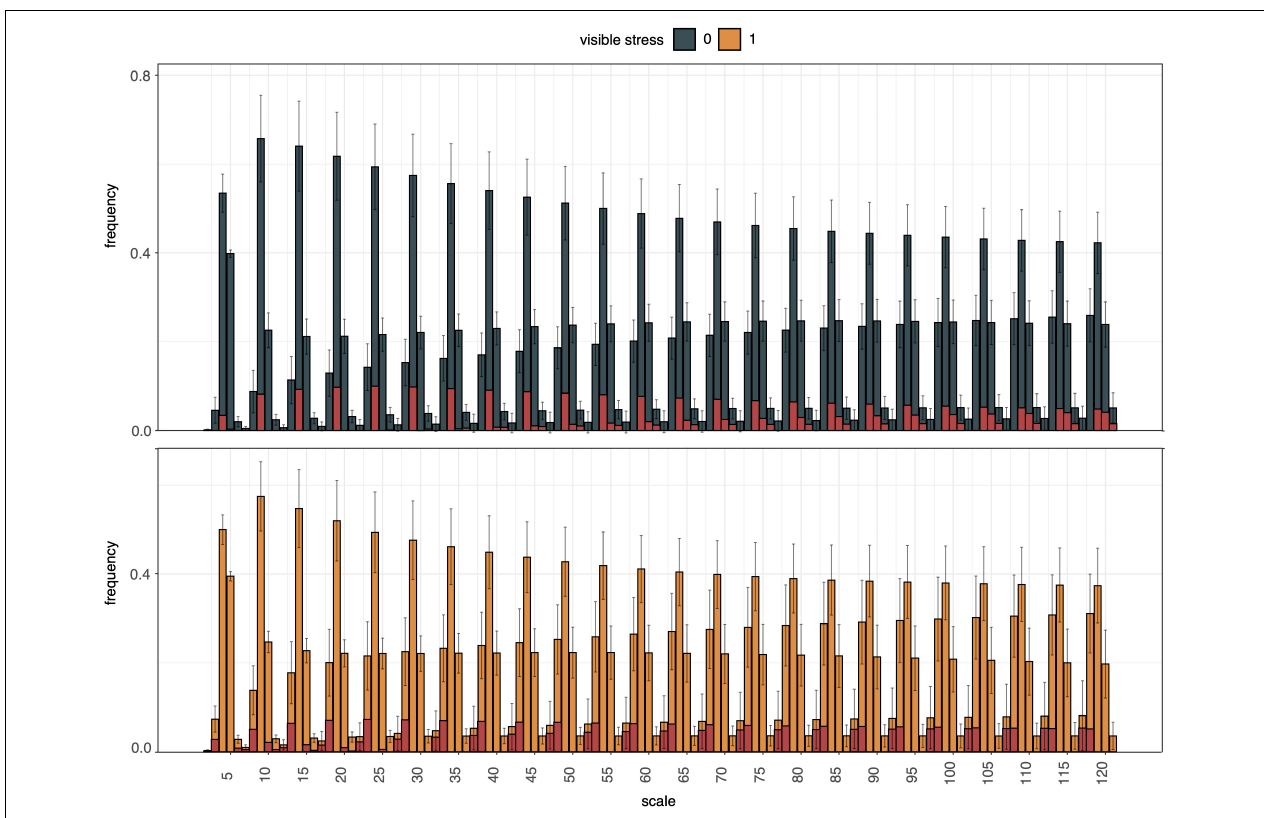
FIGURE 9 | Summary of histogram of curvature over scale (HOCS) method for all unstressed (0, blue) and all visibly stressed (1, orange) individuals on DAS 49. Each plot shows a series of 25 histograms that are composed of 5 bins each summarizing the curvature of the segmentation boundary at a given scale. Error bars give standard deviations across all individuals in each group (unstressed, visibly stressed). Overall histogram distributions were visibly different between these two groups (highlighted by red column portions signifying absolute mean differences for each bin). However, high within-group variation across the diversity panel masked these between-group differences and prevented accurate drought stress prediction from curvature of segmentation boundaries alone. TABLE 2 | Mean ROC AUC, and mean accuracies for drought stress identification from image-derived traits for 50 B. napus genotypes using different machine learning algorithms. Drought stress